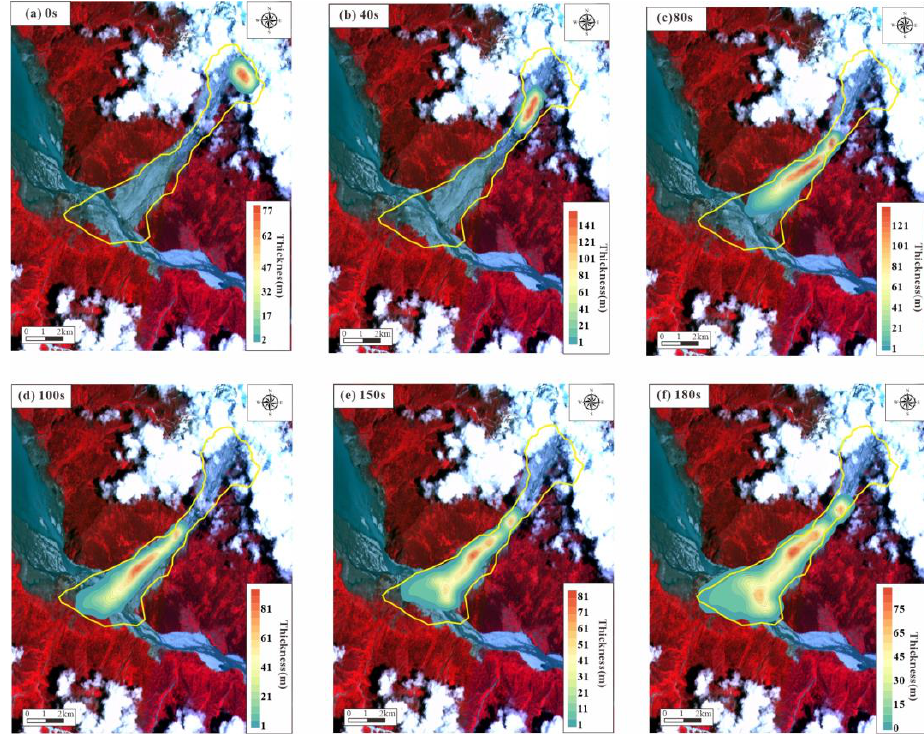
Figure 8. Contour map of the inversion simulation process of the 2000 Yigong landslide. ( a – f ) show six typical contour maps selected from the simulation process of 0 s – 180 s. The yellow line represents the actual landslide range in 2000.